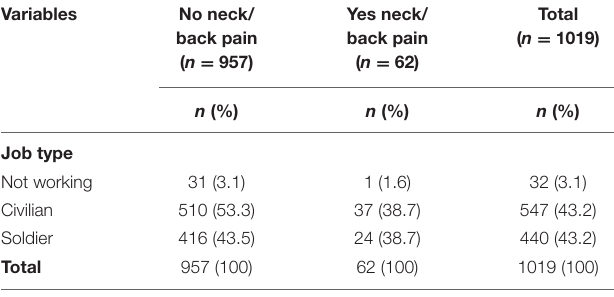
TABLE 2 | Comparison between job type and Neck/Back pain status in the Al-Kharj population sample ( n =